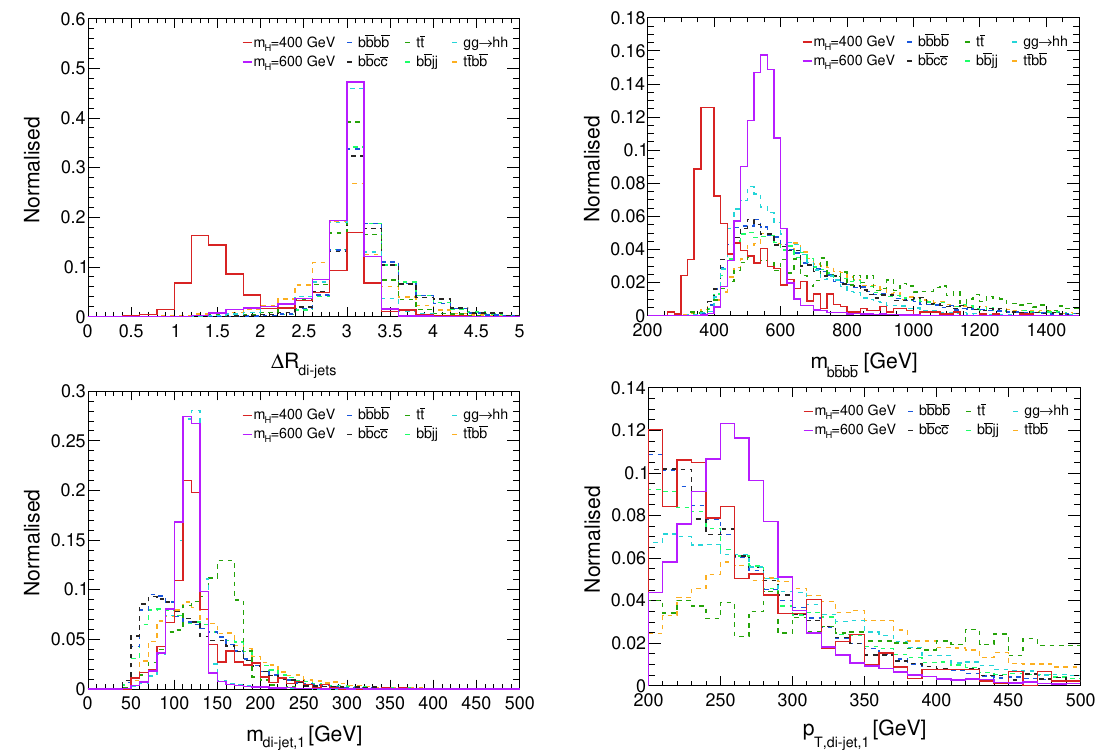
Figure 12 . The (cid:1) R di-jets , m 4 b , m di-jet,1 and p T; di-jet,1 distributions for heavy Higgs masses of m H = 400 and 600 GeV with backgrounds. Here the heavy Higgs boson is searched for in the 4 b (cid:12)nal state. The distributions are shown after imposing the cuts mentioned in table 8.